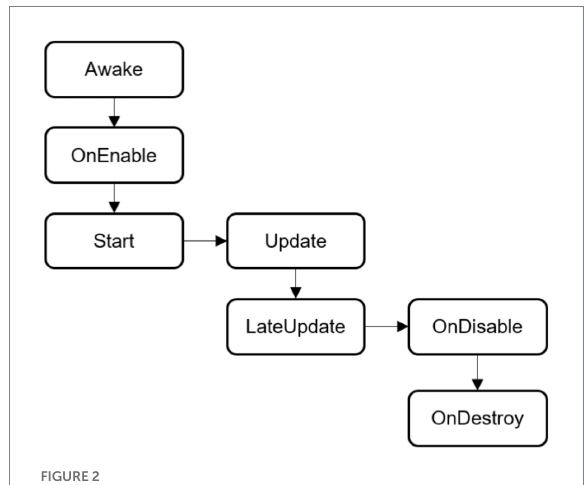
FIGURE 2 Execution sequence of common event functions of unity